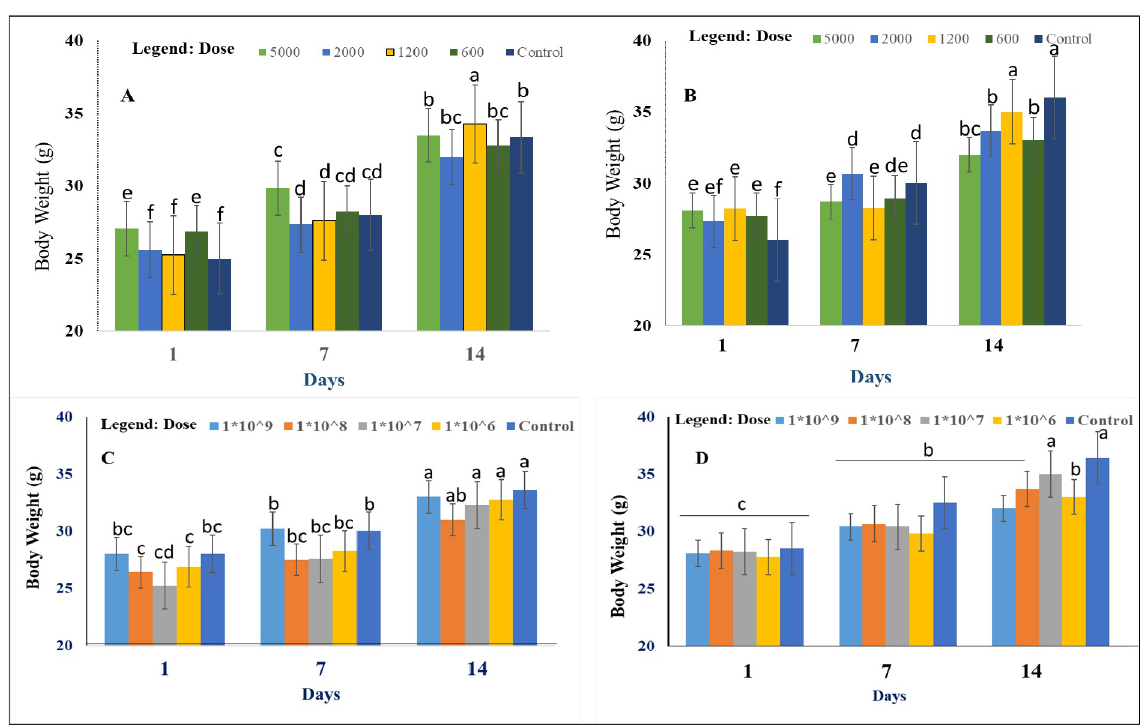
Fig 4. Changes in the body weights of mice administered with crude extracts and spore suspensions from Trichoderma species. ( A and C ) T . asperellum AU131 and ( B and D ) T . longibrachiatum AU158. ( A and B ) Mice that were administered with methanolic crude extracts and ( C and D ) mice that were administered with spore suspensions. Different alphabets depicted in superscript indicate mean treatments that are significantly different according to Tukey’s HSD posthoc test at p � 0.05, each value is an average of 5 replicate samples ± standard error. Each point represents the mean value ± SD (n =